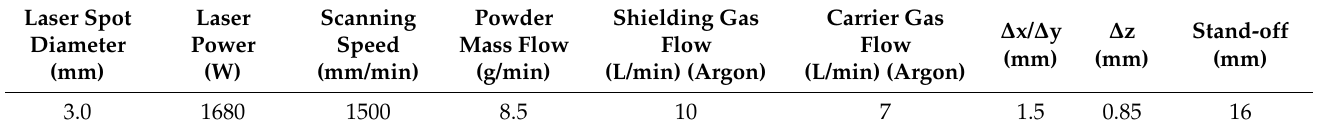
Table 2. L-DED parameters, used in the present study for the manufacturing of preforms.